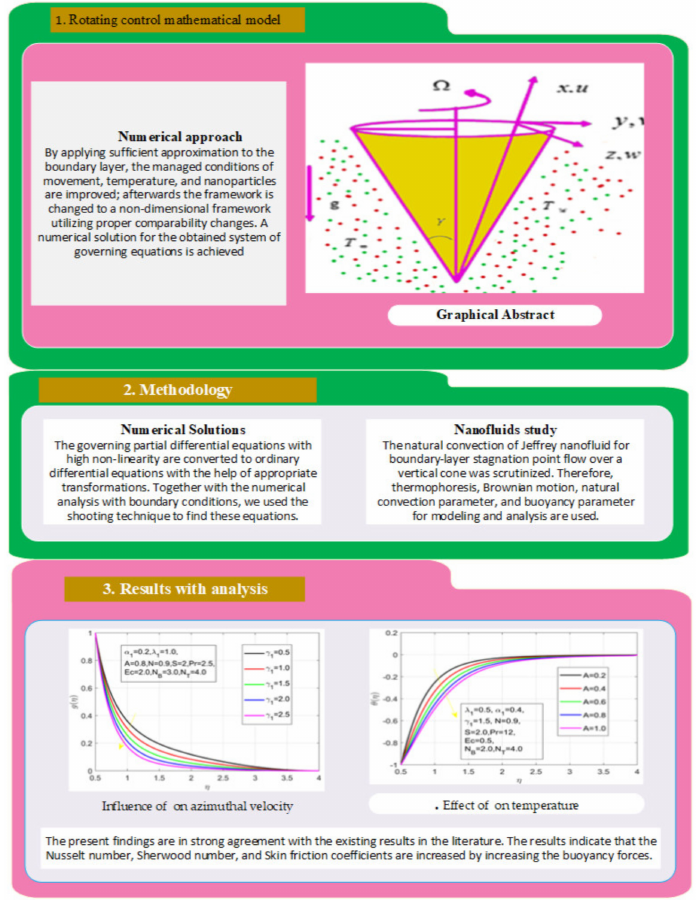
Figure 2. Workflow-based mathematical rotating cone flow nanofluid model using the numerical